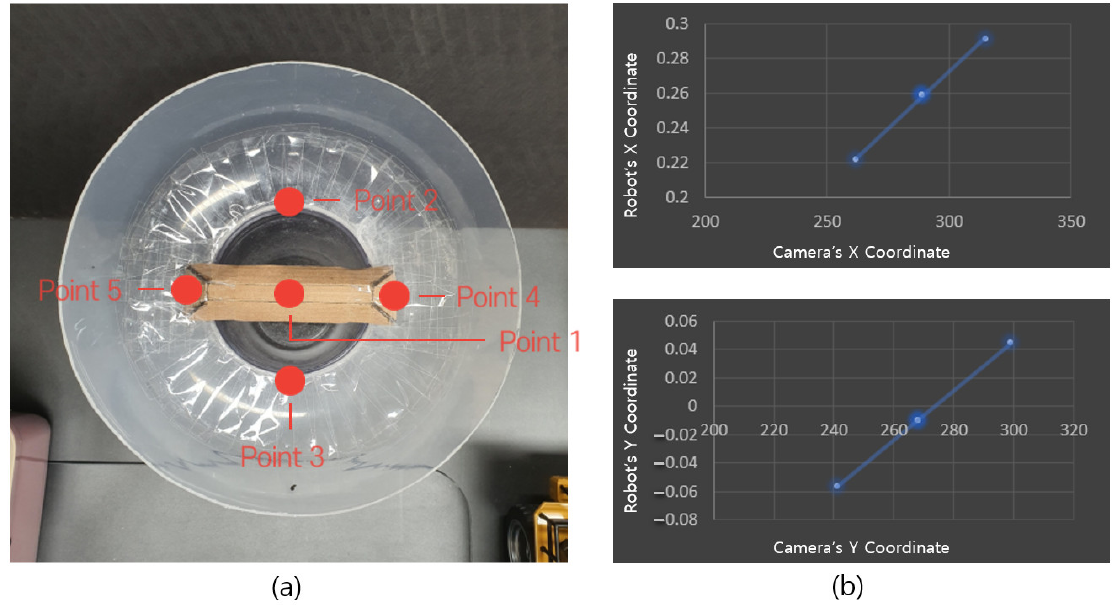
Figure 10. The calibration points for correcting the coordinate system between the RGB-D camera and the robot arm ( a ), and the relationship graph between the camera and the robot’s x and y coordinates ( b ). Table 2. Coordinates with respect to the camera and the robot arm corresponding to the five cali- bration positions.